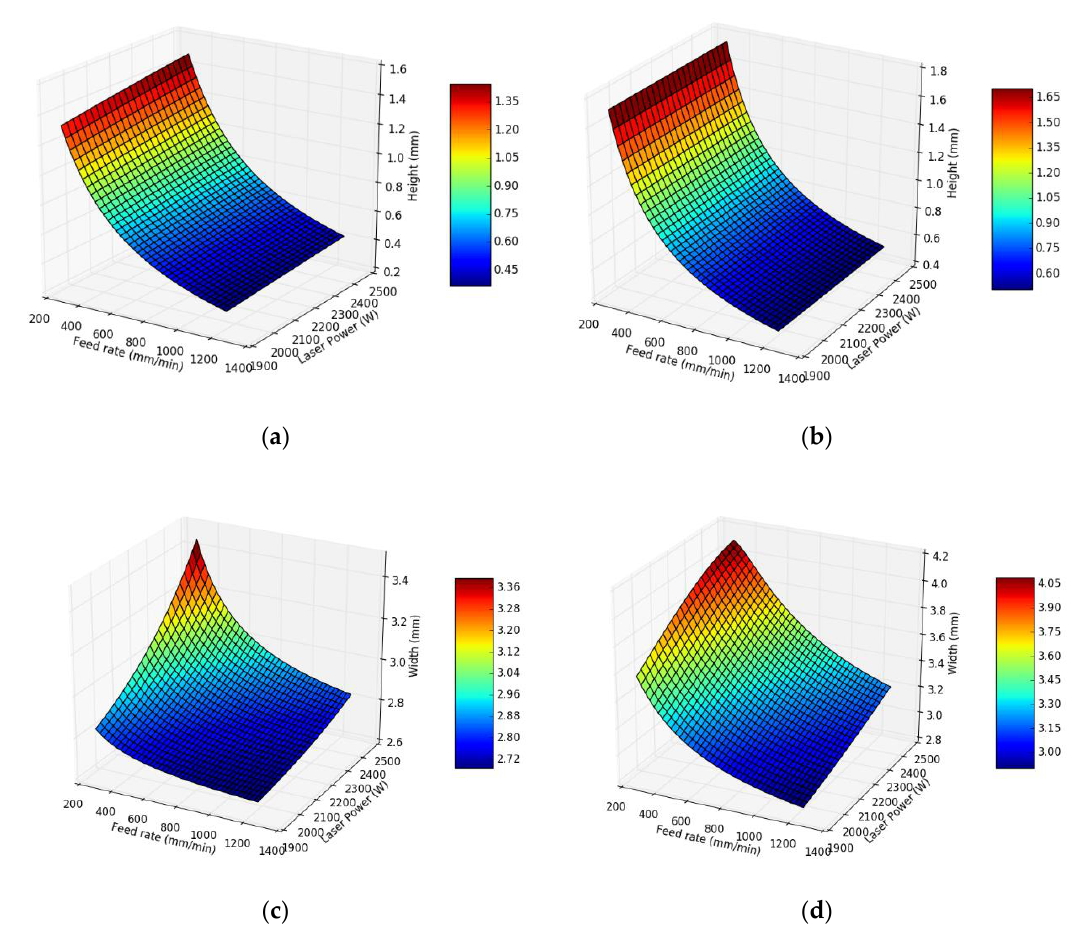
Figure 7. Results of the single-clad study at 14 g·min −1 : ( a , c ) four-stream nozzle; ( b , d ) continuous coaxial nozzle.